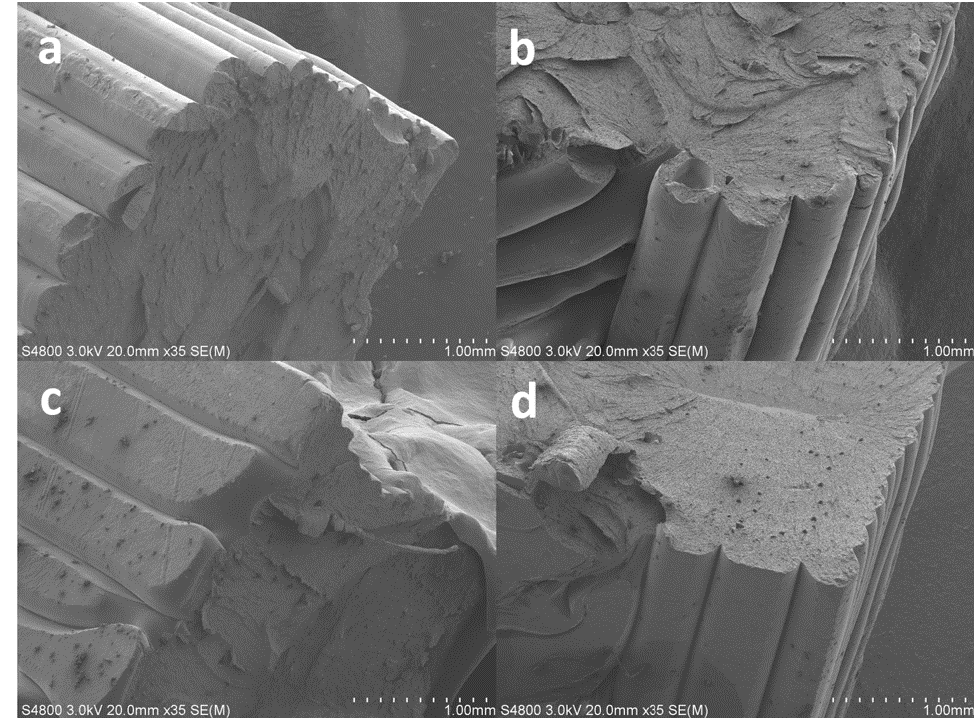
Figure 11. SEM images of the broken 3D printed specimens with a 0.18 mm layer thickness: ( a ) R-